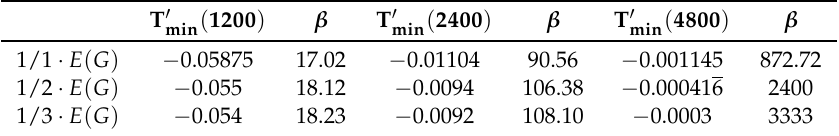
( C s ) and β calculated for different threshold values of E ( G ) and C s . Table 7. Summary of T (cid:48) min